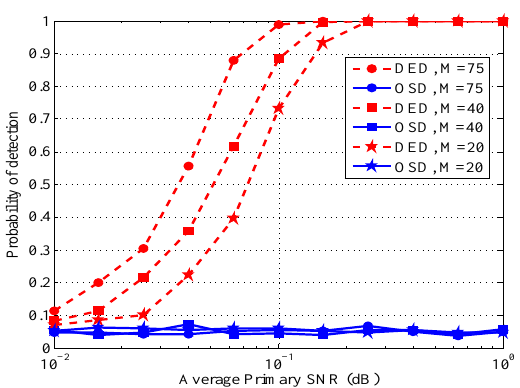
Figure 8. Probability of detection: DED and OSD vs. average primary SNR for different M | Rayleigh fading | Mixture Gaussian noises | Gaussian primary signal.